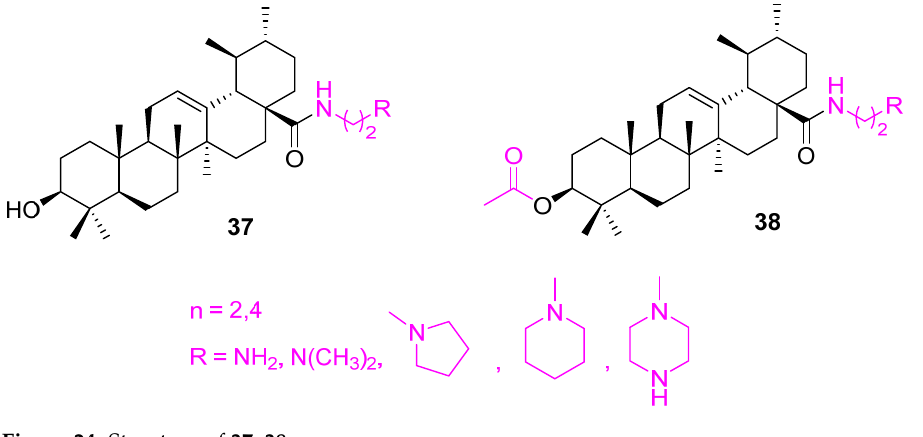
Figure 24. Structure of 37 , 38 .